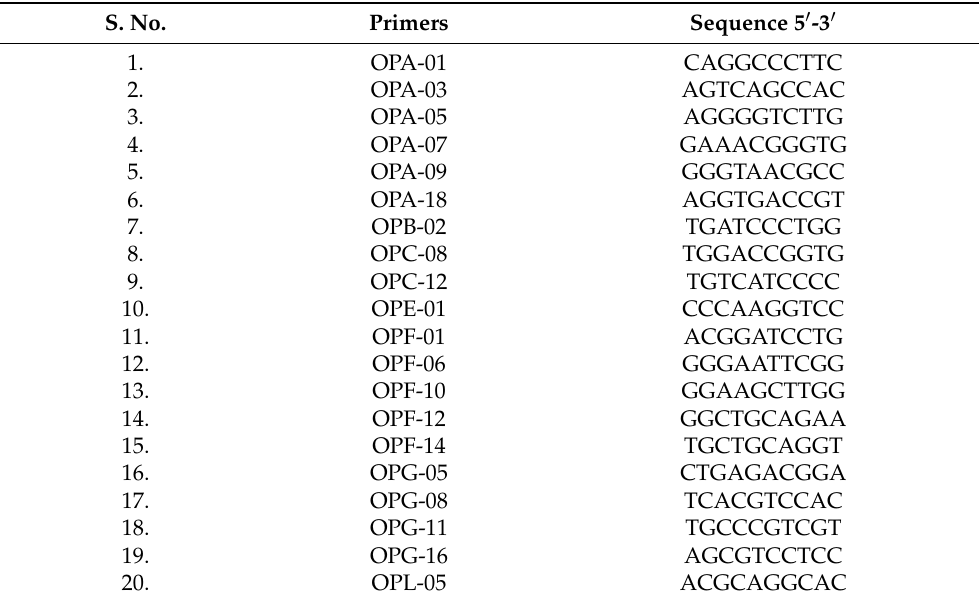
Table 1. Primers used for RAPD